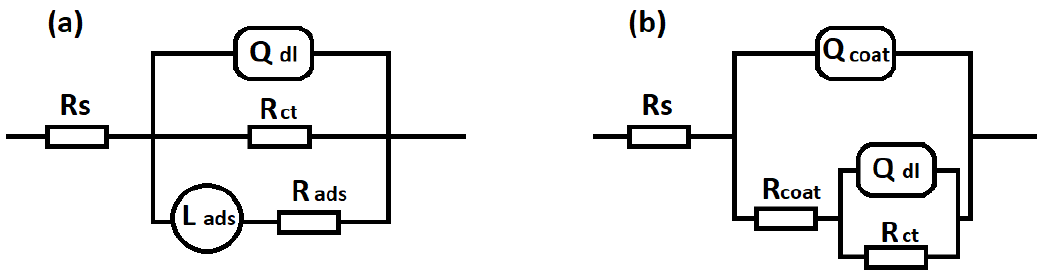
Figure 2. Equivalent electrical circuits for ( a ) uncoated and ( b ) coated AZ31B alloy specimens.